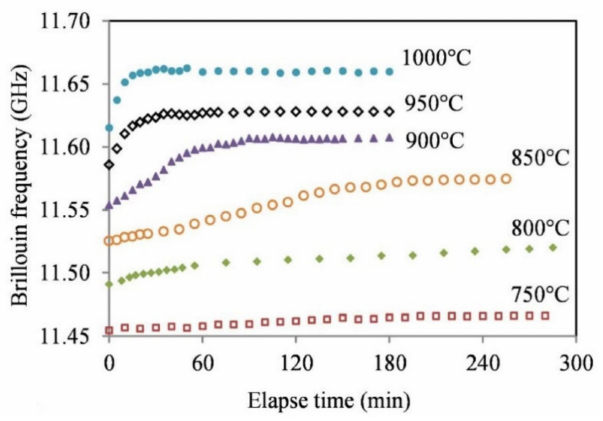
Figure 19. Isothermal Brillouin frequency drift (Reprinted with permission from [67] © The Optical Society